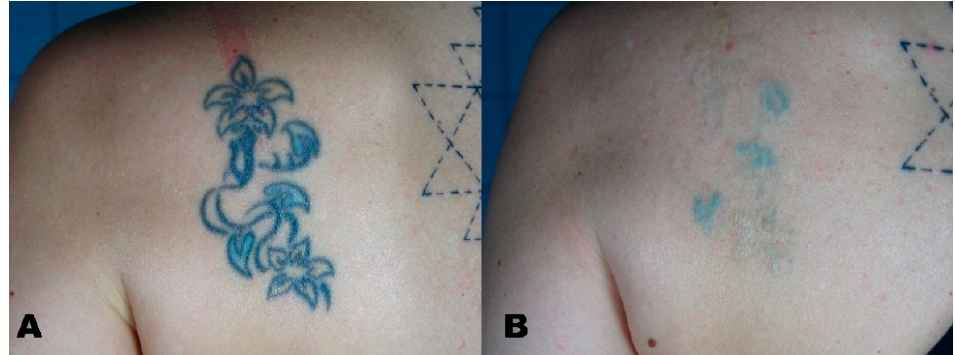
Figure 3. ( A ) Picture before starting tattoo removal treatment, and ( B ) the same region at the 6-month follow-up, after all tattoo removal sessions had been completed.